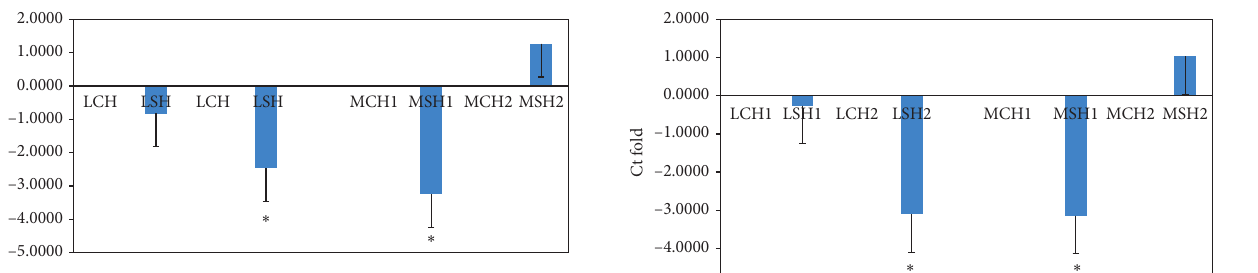
Figure 3: Comparison of relative fold change in the gene ex- pression of ghrelin receptor (GSHR) in liver (L) and magnum (M) tissues of Nicobari chicken after 10d (CH1 and SH1) and 20d (CH2 and SH2) of the experiment. C: control; S: supplemented with FYC at 700 mg/kg. ∗ P < 0 . 05 N � 4. From 21 to 23 weeks of age, the CH and SH group birds were exposed to 39 ° C for 4h under controlled